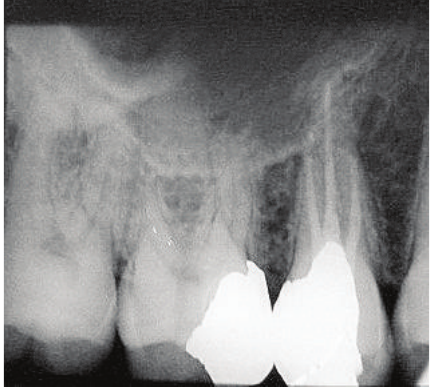
Figure 5: Three roots with three separate